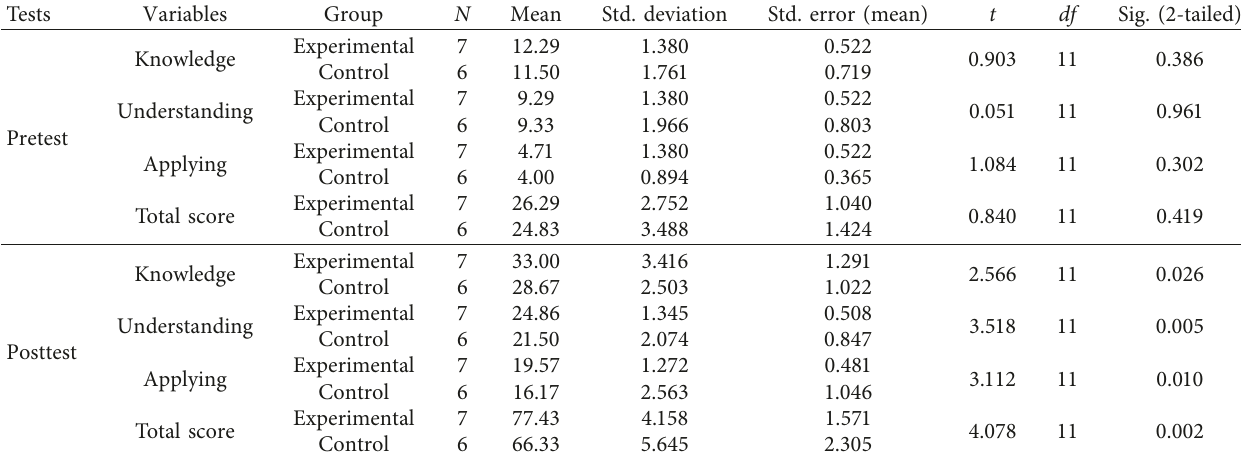
Table 8: Independent sample t -test for pre- and posttest of high-achiever students.